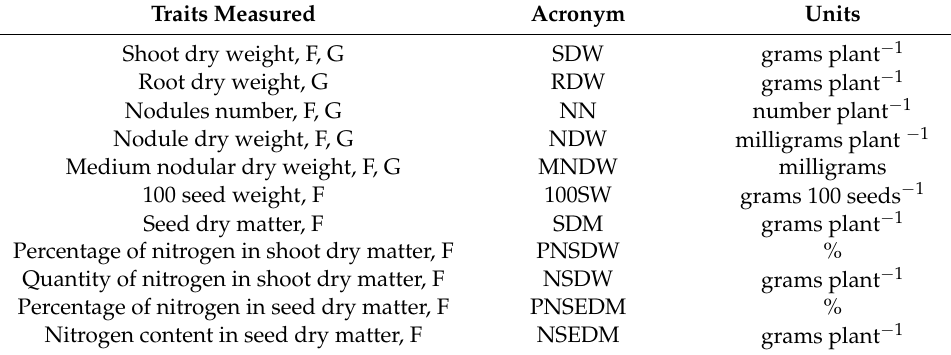
Table 2. Traits measured (F = field, G = greenhouse), acronym and units of measurement. Traits Measured Acronym Units Shoot dry weight, F, G SDW grams plant − 1 Root dry weight, G